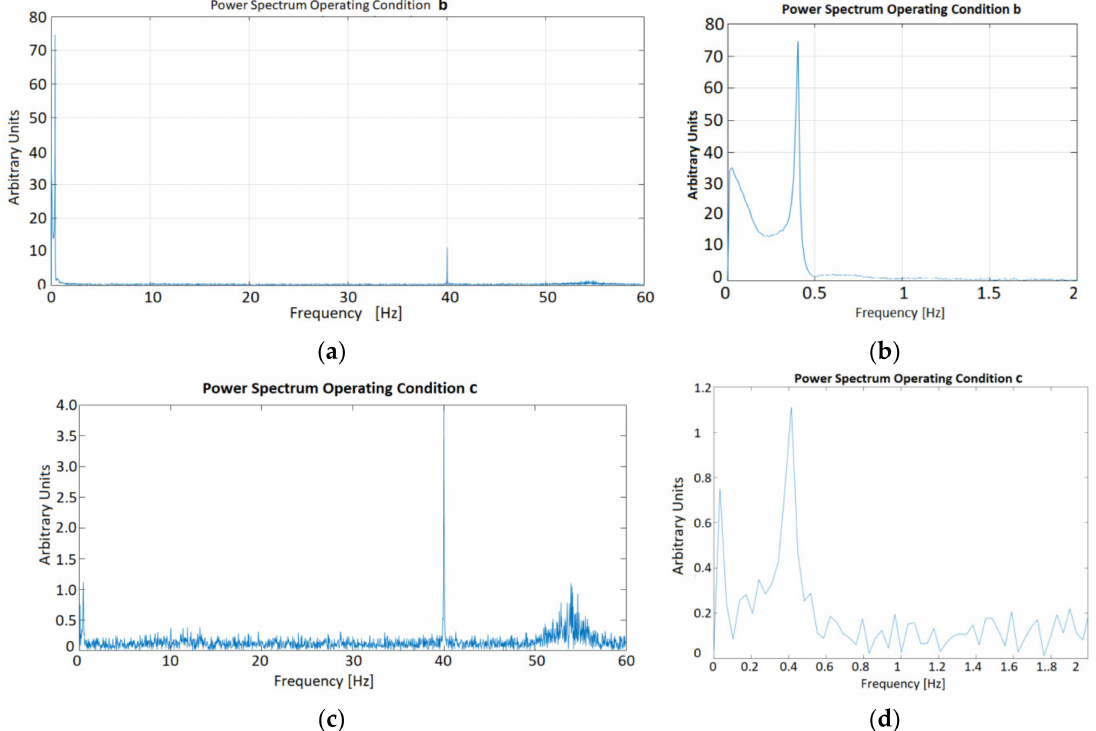
Figure 11. Spectra of vibration frequencies of point P on the wind tower located at H = 60 m. Spectrum for the data collected during the deactivation of the wind turbine ( a ). Enlargement of the low frequencies ( b ). Spectrum for the data collected during the stop of the wind turbine ( c ). Enlargement of the low frequencies ( d